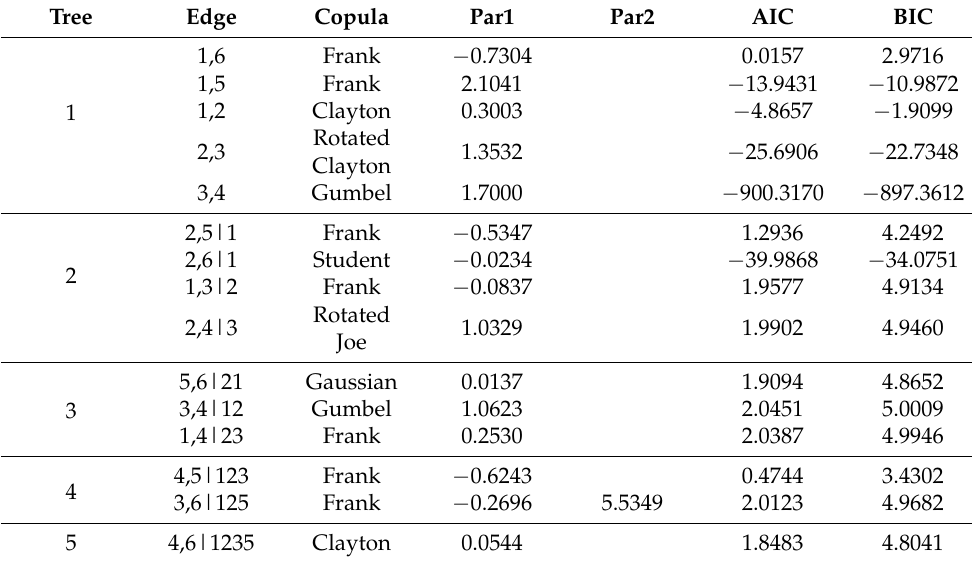
Table 4. Parameters of R-vine Copula model.